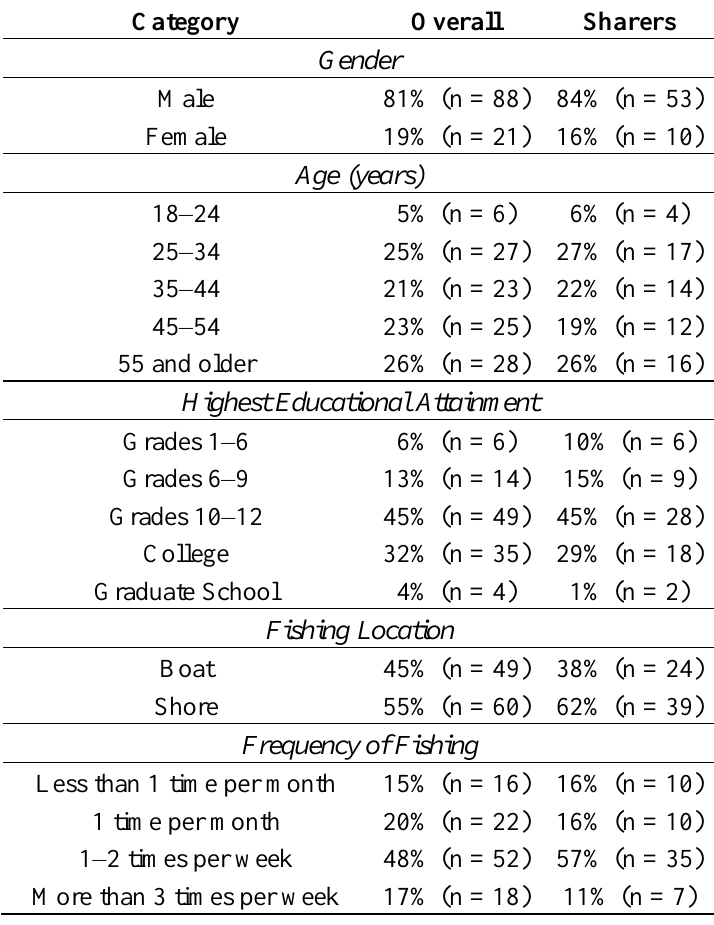
Table 1. Demographic characteristics of overall sample of fish consumption advisory study participants at Badin Lake, NC, USA compared to a subsample that shares fish caught with women and